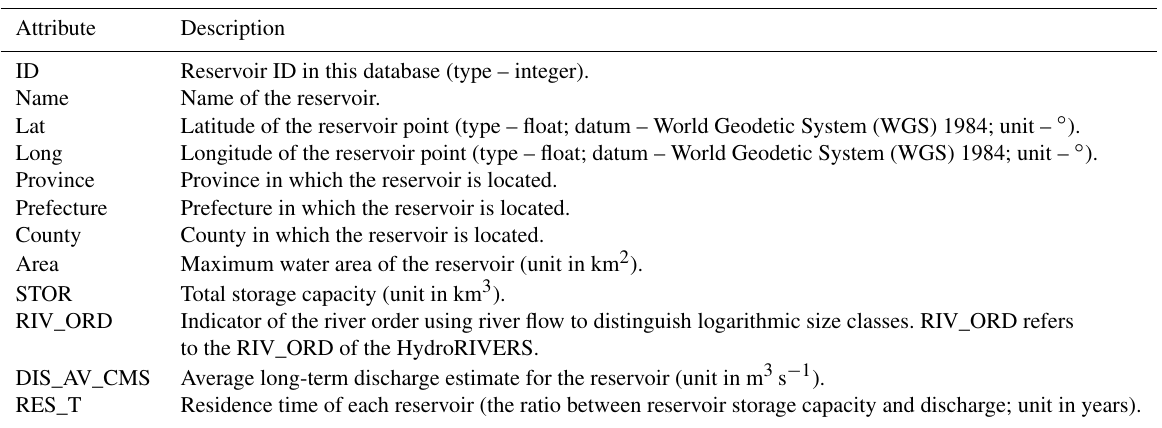
Table 2. Attributes in all (97435) reservoirs from